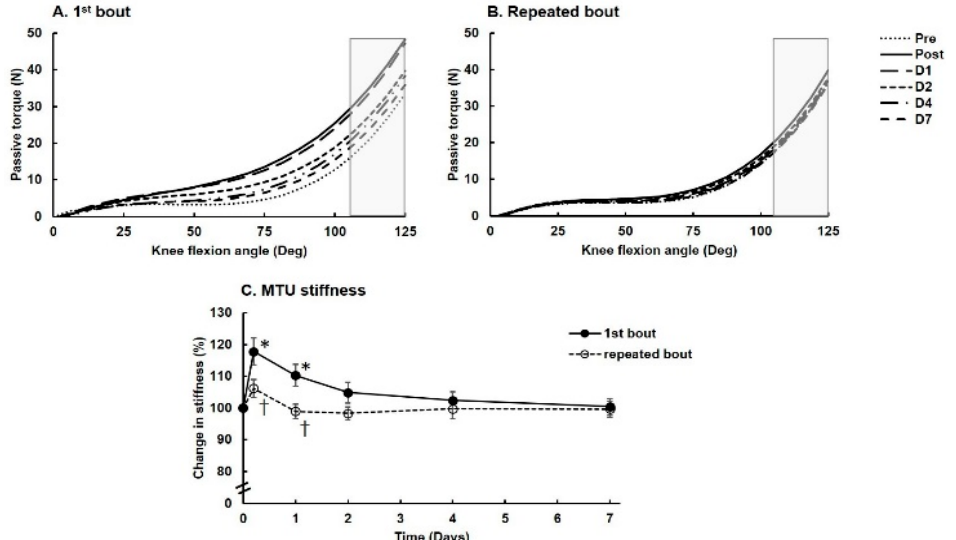
Figure 2. Changes in passive MTU stiffness of the knee extensors. Angle–torque relationships for ( A ) the first bout and ( B ) the repeated bout. The gray shaded boxes indicate the stiffness calculation for the last 15° (110–125°) of passive knee flexion. ( C ) Passive MTU stiffness after 7 days is shown as mean and SEM ( n = 11). Filled circles and solid lines are data for the first bout; open circles and dashed lines are data for the repeated bout. * Significantly different from the pre-exercise value ( p < 0.05). † Significantly different from the first exercise bout ( p < 0.05).